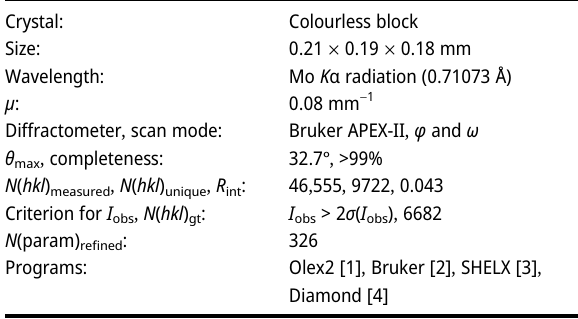
The molecular structure is shown in the fi gure. Table 1 contains crystallographic data and Table 2 contains the list